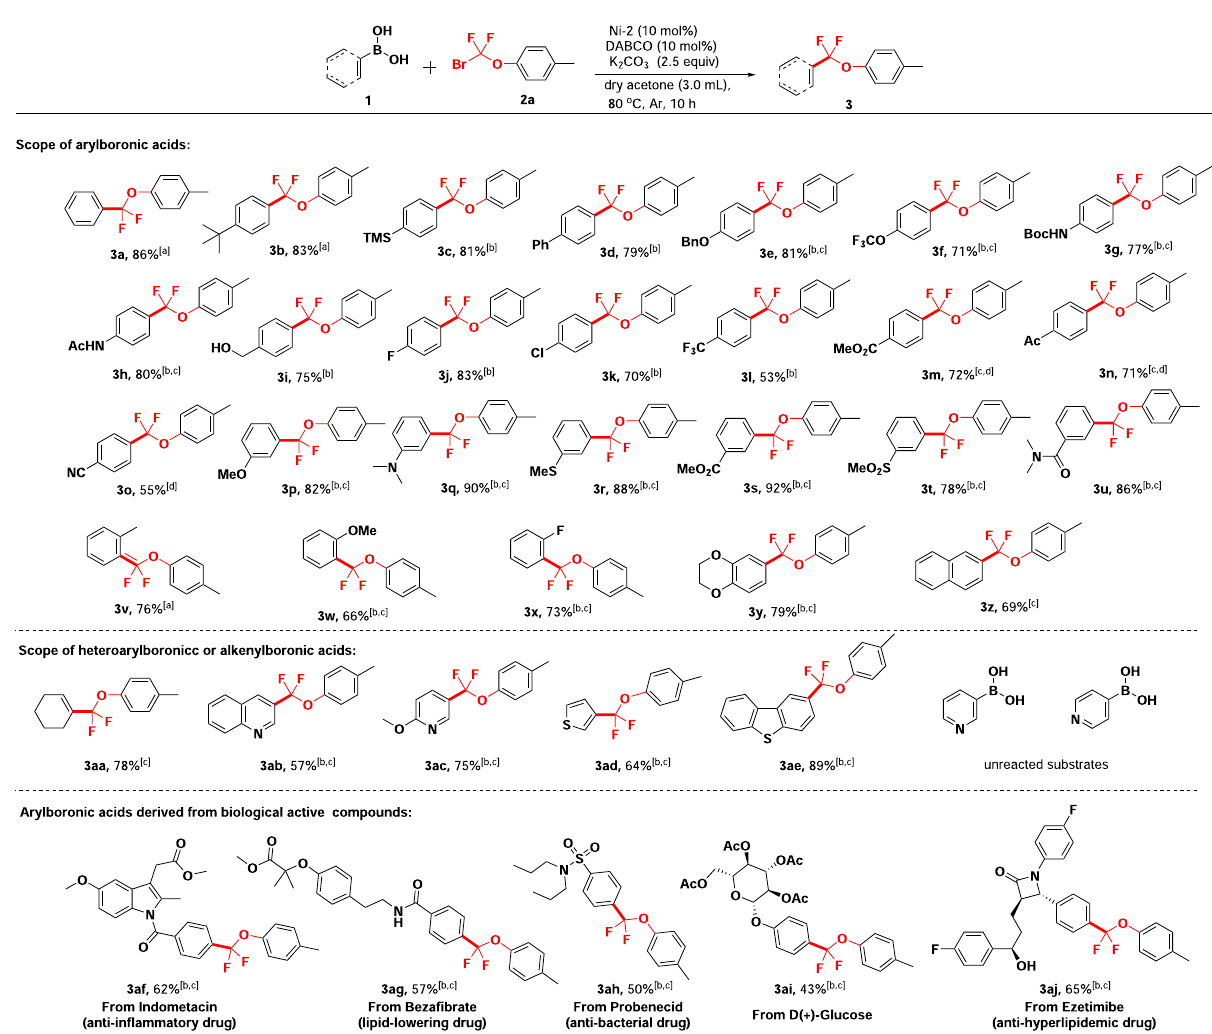
Fig. 2 Ni-catalyzed aryloxydi fl uoromethylation reactions with diversi fi ed arylboronic acids. a Reaction conditions: unless otherwise noted, a solution of 1 (0.2 mmol), 2a (0.4 mmol), Ni-2 (10 mol%), DABCO (10 mol%), and K 2 CO 3 (0.5 mmol) in dry acetone (3.0 mL) was performed at 80 o C under argon for 10 h. The yields are isolated yields by column chromatography on silica gel. b Dry acetone (2.5 mL) and DMF (0.5 mL) were used for solvent. c 100 mg 4 A MS was added. d Dry acetone (1.5 mL) and DMF (1.5 mL) were used for